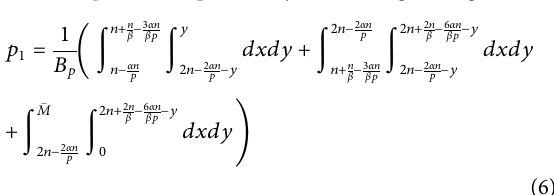
FIGURE 2 Users who choose Package 2.